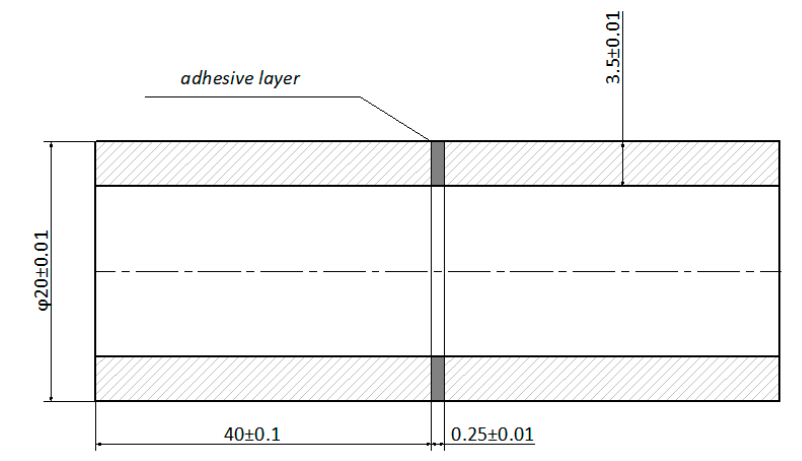
Figure 2. Scheme of adhesive joint of PP pipes with a diameter of 20 mm (PP-20) (dimensions in mm).